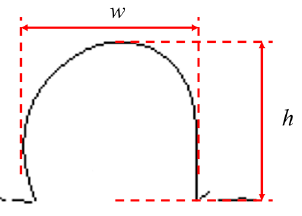
Figure 7. Diagram of the maximum width and length of the air bubble.